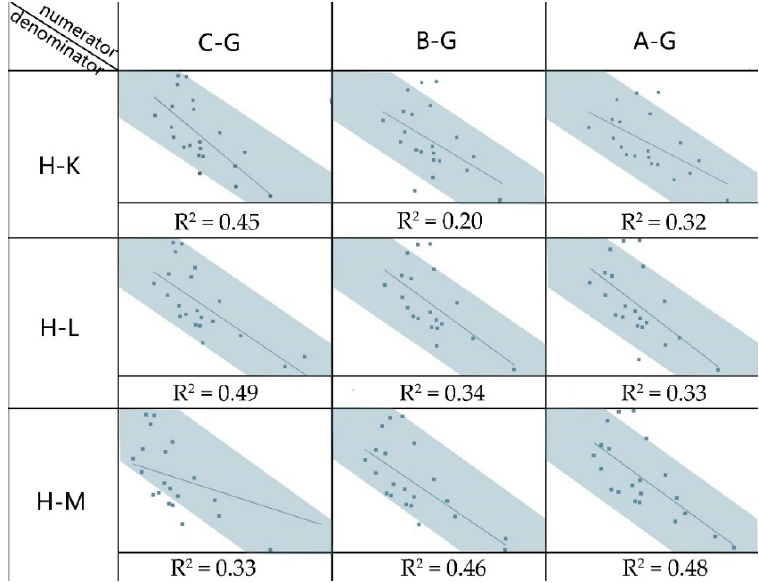
Figure 10. Correlation between different wavelength ranges and tone angles. Table 2. Iron content and tone angle of samples no. 2–3, 3–7, 3–9, 3–2, 2–1, 3–3, and